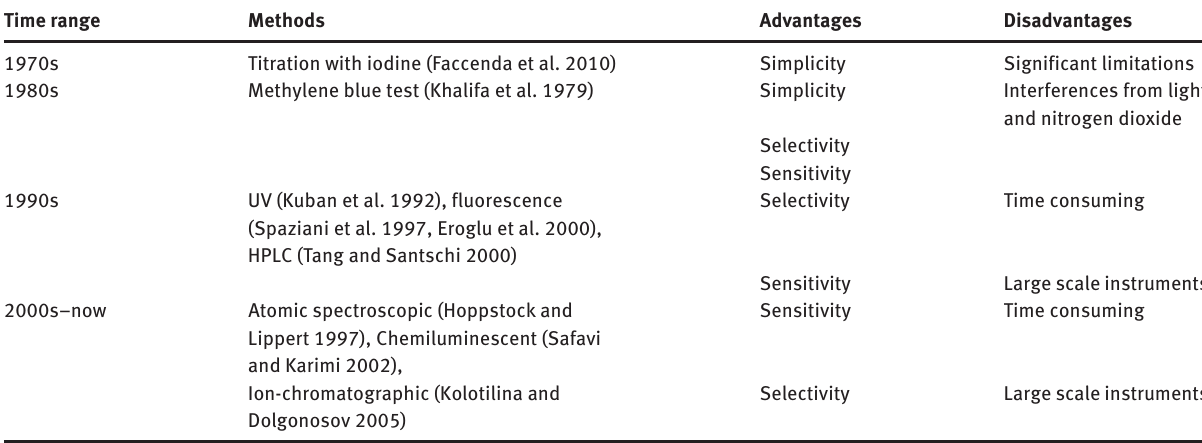
Table 1 Different methods used in different